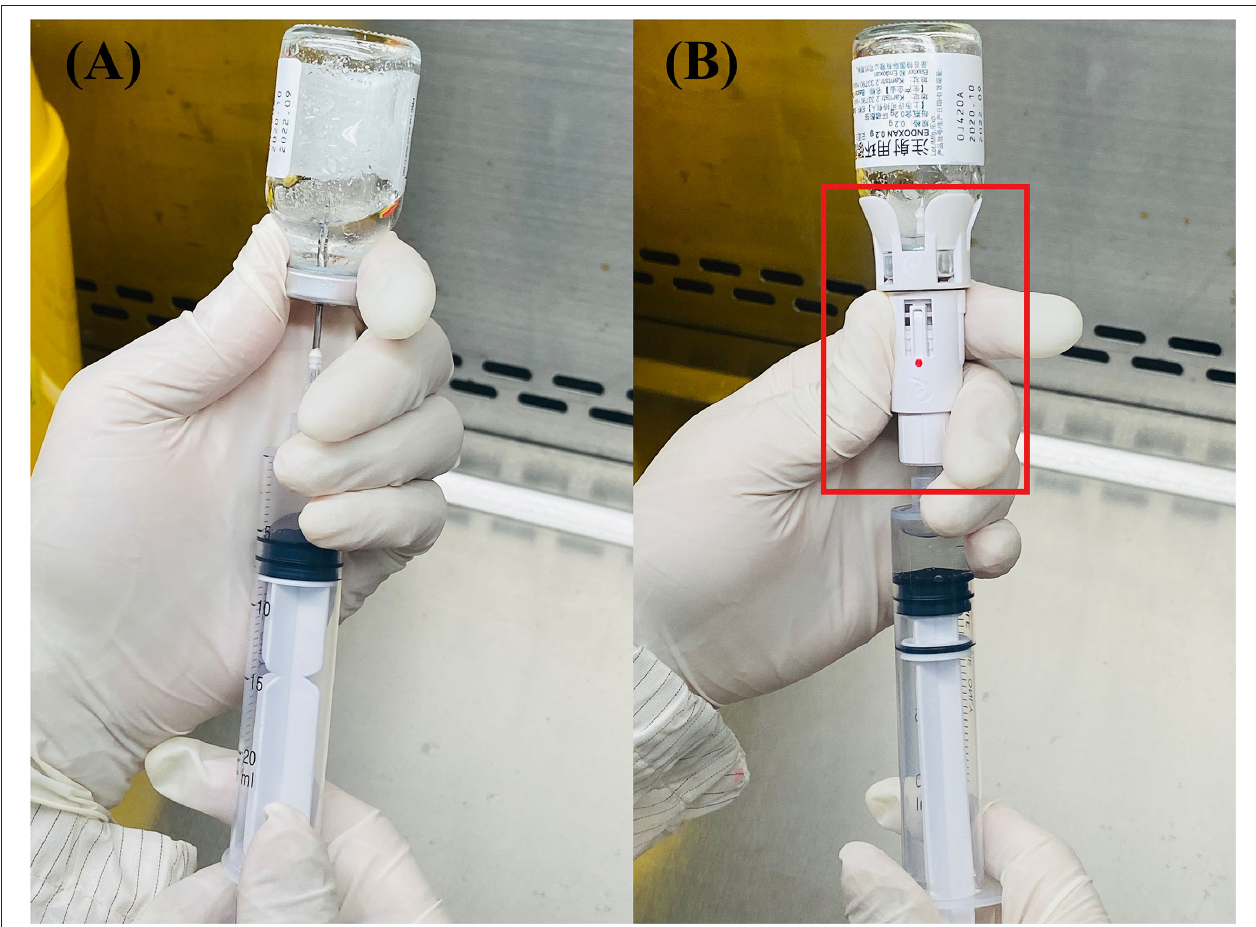
FIGURE 1 | The structure of these two systems: traditional (A) and closed system transfer devices (CSTD) (B) From Shinva Ande Healthcare Apparatus Co., Ltd.